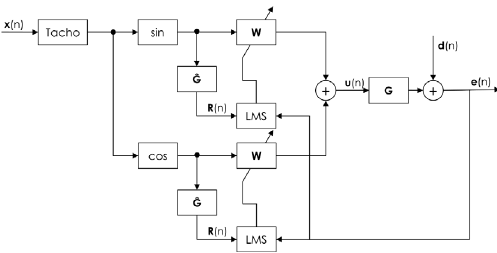
Figure 7. Block diagram of the single-frequency Fx-LMS